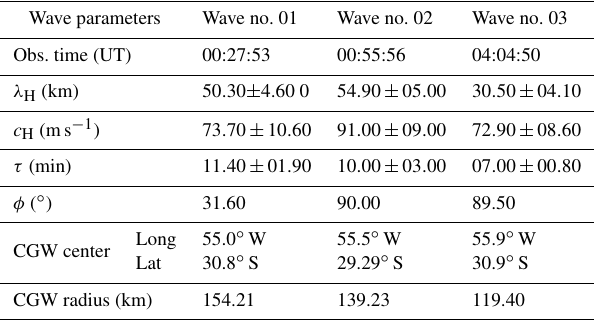
Table 1. Parameters of excited waves during the 1–2 October 2019 CGW